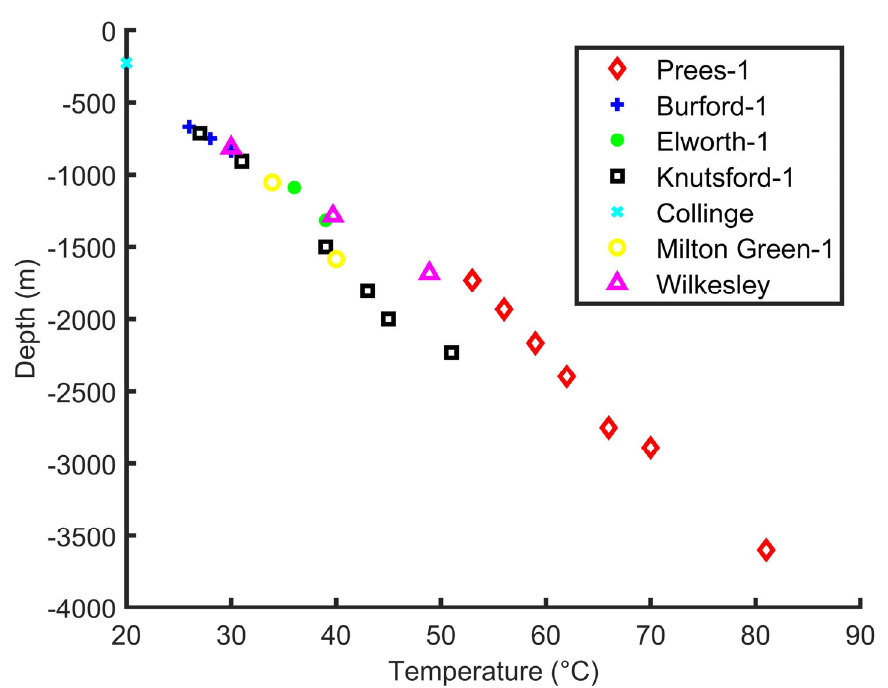
Figure 4. Temperature vs. depth plot. Data collated from Burley [60], Busby [17], Hirst et al. [21], Plant et al. [23]. Note depth is meters below ground level and the data.